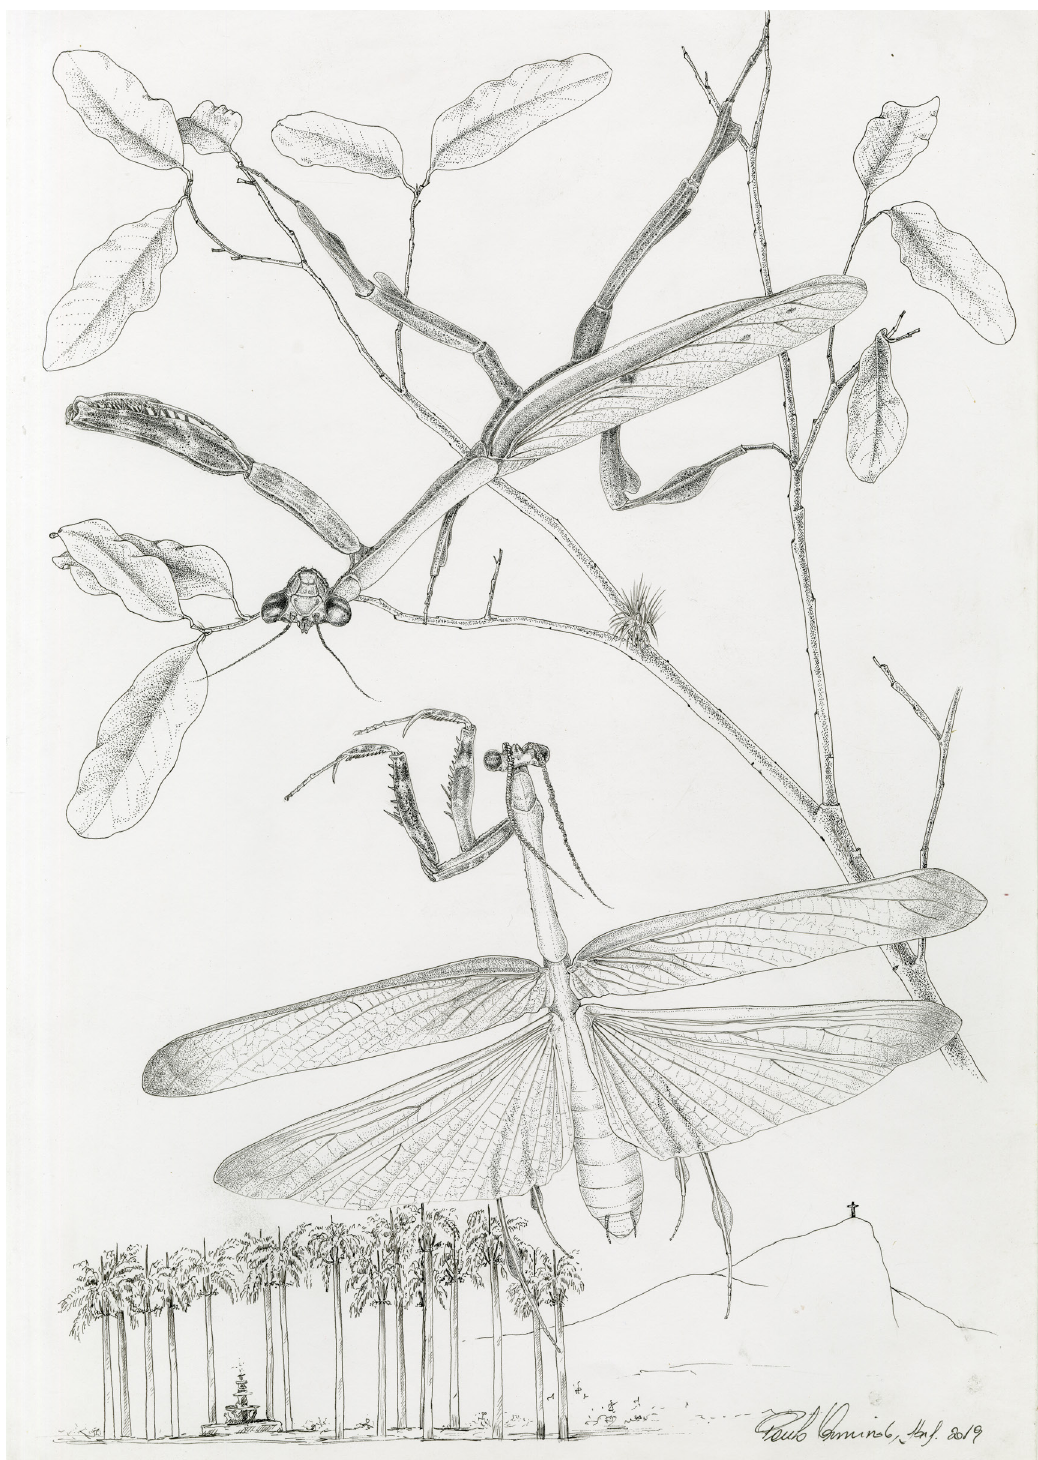
Fig. 8. Habitus of Vates phoenix sp. nov. Adult female is portrayed upside-down with raptorial legs stretched forward, perching on Licania tomentosa (Benth.) Fritsch. (‘oiti’), an arboreal species distinct from the Atlantic Rainforest and abundant within the general area where the female allotype was found. A male specimen is depicted flying, as they often are on the wings through adulthood. Scientific illustration executed by Paulo Ormindo, based on observations of wild